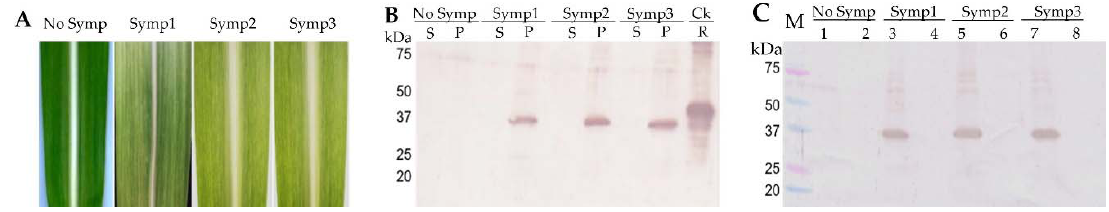
Figure 5. Detection of SCMV infection in sugarcane leaves using western blot analysis. ( A ) Photograph of healthy no-symptom and symptomatic sugarcane leaves; and ( B , C ) western blot analysis of the proteins extracted from the leaves sample using S5 serum; ( B ) the protein extract prepared by high speed centrifugation and ( C ) low speed centrifugation. No Symp and Symp represent no-symptom and symptomatic leaves. S, P, R (Ck), and M are soluble, insoluble, recombinant (control) protein, and marker proteins, respectively.